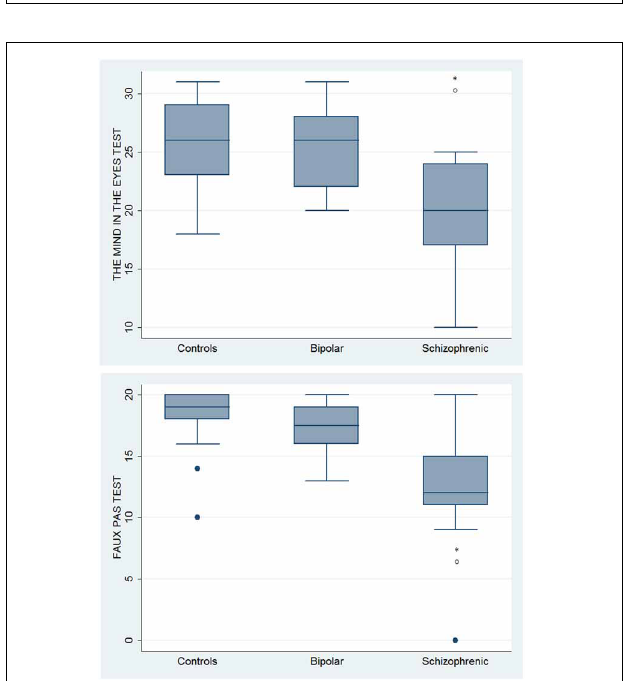
FIGURE 6 | Differences between HC and SKZ in neuropsychological tasks: BACS Tower of London test. • Outliers. ∗ Significantly different from HC ( p < 0 . 05).